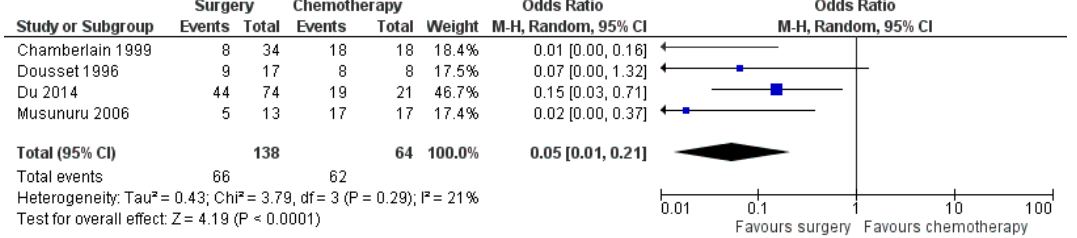
Figure 4. Forest plot for overall survival (OS) after any surgery versus chemotherapy.